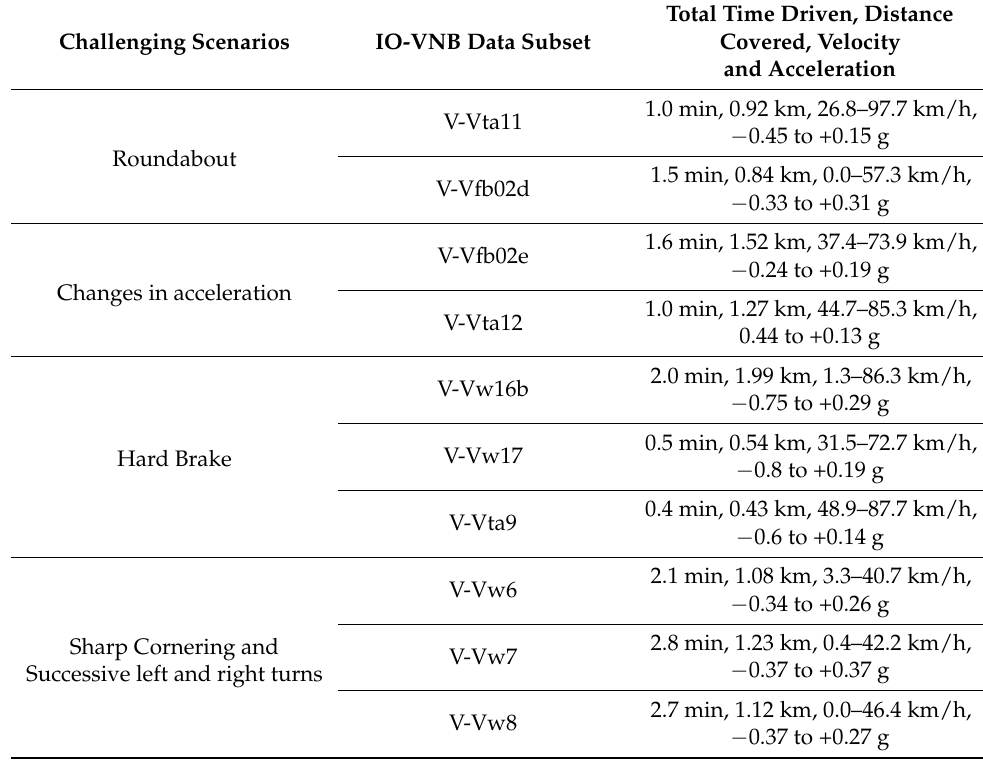
Table 3. IO-VNB data test subset used in the challenging